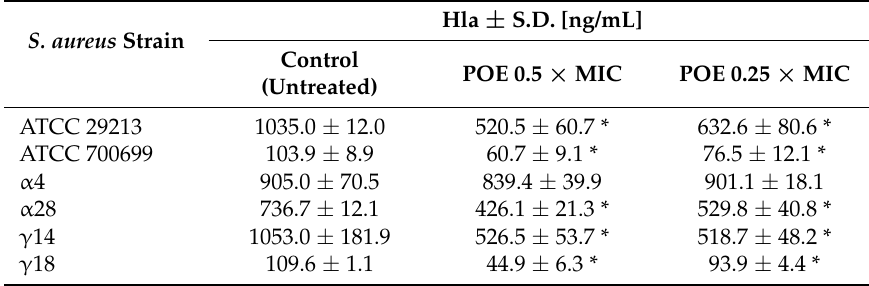
Table 1. The effect of POE used at 0.5 × and 0.25 × MIC on α -toxin (Hla) production by S. aureus reference and clinical strains (n = 2 + 4) tested by